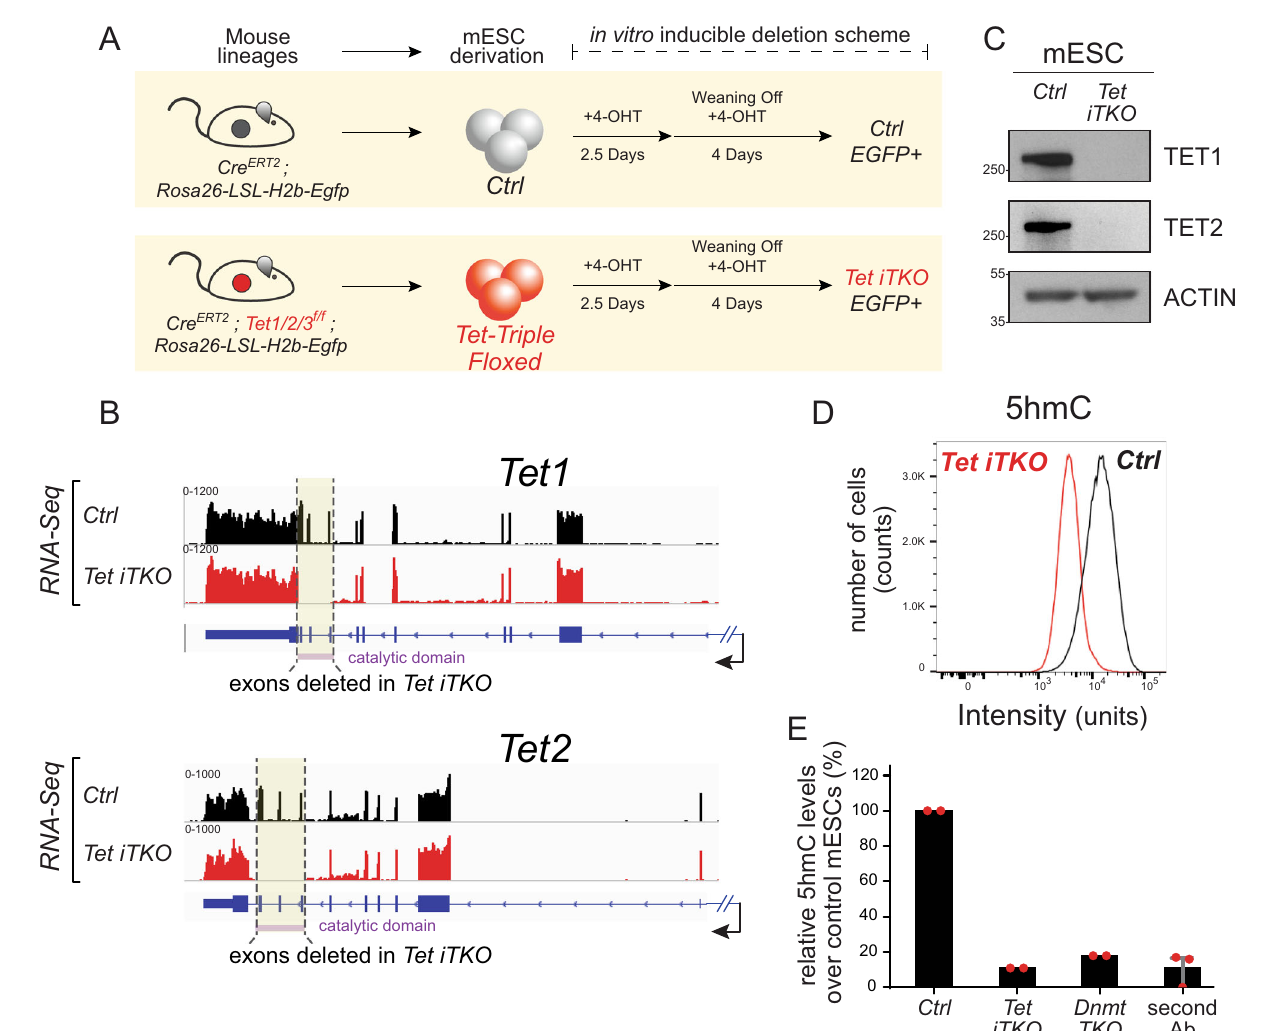
Fig. 1 | Generation of a tamoxifen-inducible Tet1/2/3 triple-deletion system in mESC.A MousestrainsexpressingtheCreERT2recombinaseforinducibledeletion were established in house and used to derive mESC populations that were grown under 2iconditions. Genotypes wereControl ( Ctrl ): CreERT2;Rosa26-LSL-H2b-Egfp ; Tettriple fl oxed(Tet T fl ) : Tet1/2/3 fl / fl ; CreERT2;Rosa26-LSL-H2b-Egfp . Acute deletion of all three Tet genes to yield Tet1/2/3 inducible knockout ( Tet iTKO ) mESC, with concomitant expression of the H2B-eGFP reporter, was accomplished by culturing the cells for 2.5 days in 4-OHT, followed by 4-OHT removal and culture for an additional 4 days before analysis. B Genome browser views of Tet1 and Tet2 tran- scripts generated by RNA-Seq analysis of Ctrl (black tracks) and Tet iTKO (red